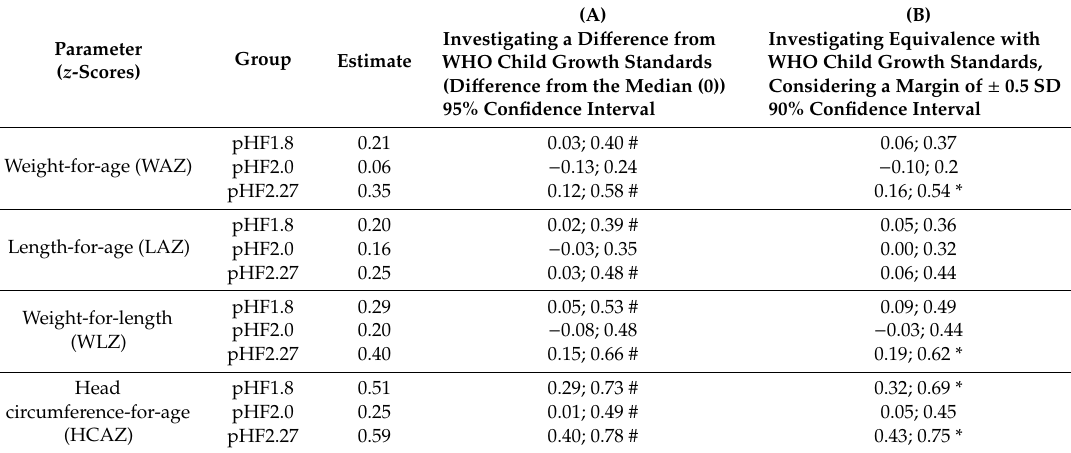
Table 4. Estimated (LS mean, 95% CI and 90% CI) z -scores of growth outcome parameters at 12 months age of the per protocol population to evaluate (A) di ff erences from WHO Child Growth Standards using the 95% CI and (B) equivalence to WHO Child Growth Standards using the 90%